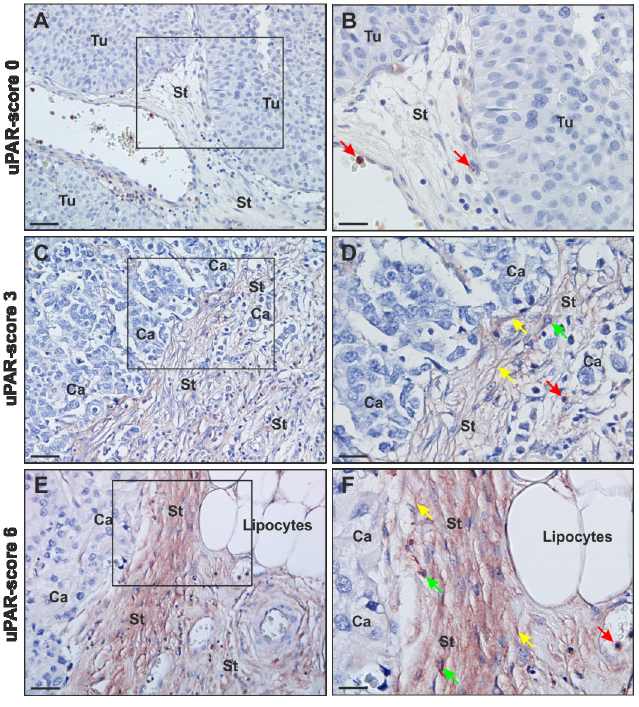
Fig 1. uPAR immunohistochemistry in urothelial neoplasia of the bladder. The figure shows examples of different uPAR scores at the invasive front of the tumour: uPAR score = 0 (no uPAR positive cells detected), uPAR score = 3 (between 5% and 10% positive cells), and uPAR score = 6 ( > 70% positively stained cells). Tissue sections stained with a pAb against uPAR. uPAR expression was scored semi- quantitatively. The antibody was visualised with NovaRed. uPAR immunoreactivity was scored separately in cancer cells, macrophages and myofibroblasts. The black squares in A, C and E are shown in higher magnification in B, D and F. uPAR immunoreactivity was primarily seen in myofibroblasts ( yellow arrow in D and F) and macrophages ( green arrow in D and F) in the surrounding stroma. uPAR positive neutrophils served as internal control ( red arrow in B, D and F). Tu: tumour, Ca: cancer, St: stroma. Bar in A, C and E ~ 50 μ m. Bar in B, D and F ~ 25 μ